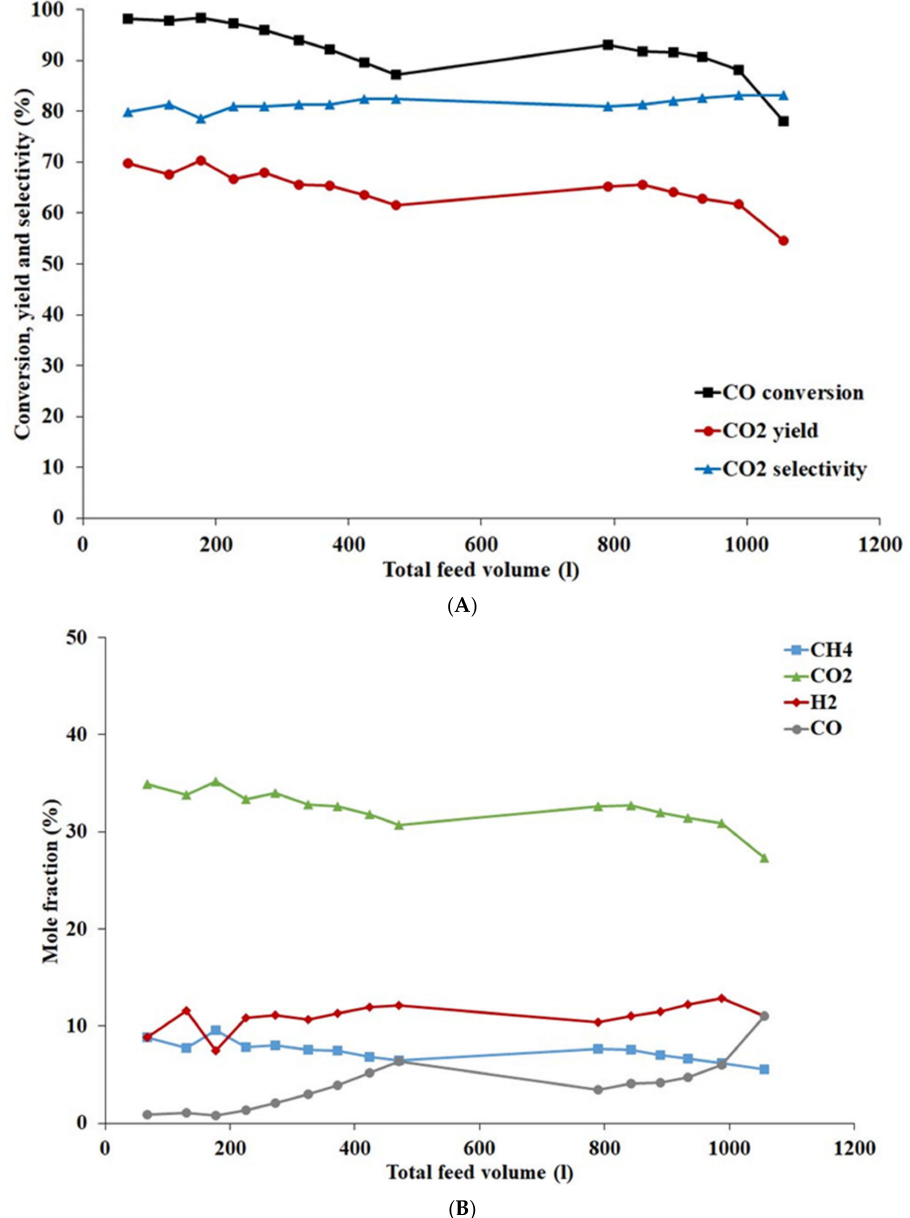
Figure 6. Catalytic tests with feed gas mixture 2 (50 mole% CO, 0.4 mole% H 2 S, balance N 2 ) at 0.5 MPa pressure over a commercial Ni-based catalyst: ( A )—CO conversion, CO 2 yield, and CO 2 selectivity; ( B )—composition of produced